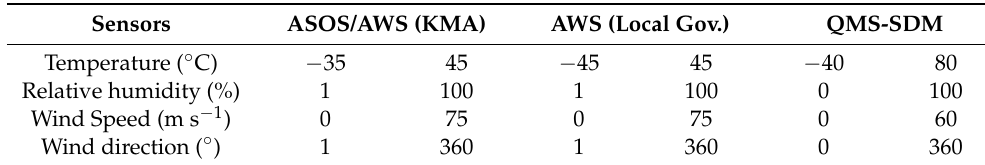
Table 4. Threshold values ( ◦ C) for air temperature climate range checks applied to the KMA ASOS/AWS, AWS by the local government, and QMS-SDM in Korea. Month ASOS/AWS (KMA) AWS (Local Gov.) QMS-SDM